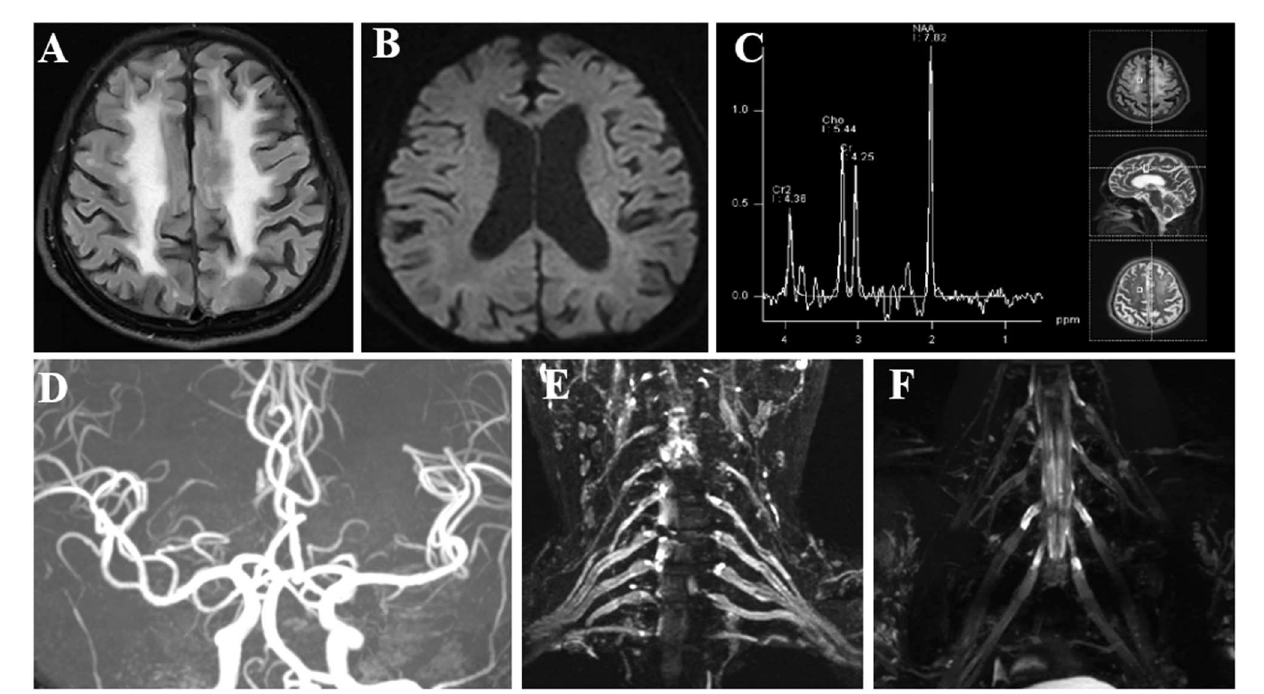
FIGURE1 Imaging examinations of the patient. (A) FLAIR sequence shows diffuse, bilateral white matter lesions with hyperintensity. (B) DWI sequence shows no characteristic hyperintense areas in the corticomedullary junction. (C) MRS focused on the frontal lesion shows no lactate peak appearance. (D) MRA shows no significant intracranial aortic stenosis or occlusion changes. (E, F) Brachial and lumbosacral plexus MRI showed extensive thickening in the nerve roots. FLAIR, fluid-attenuated inversion recovery; DWI, diffusion-weighted image; MRS, magnetic resonance spectroscopy; MRA, magnetic resonance angiography; MRI, magnetic resonance imaging.